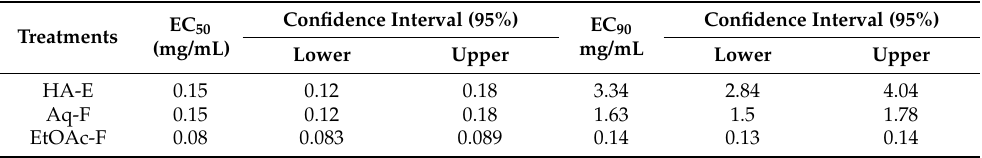
Table 3. Haemonchus contortus egg hatching inhibition percentage (EHI%) after 48 h exposure to subfractions obtained from the EtOAc fraction from Pithecellobium dulce leaves. Means of Eggs and Larvae (L1 or L2) Recovered Concentration Subfractions/Controls (mg/mL)